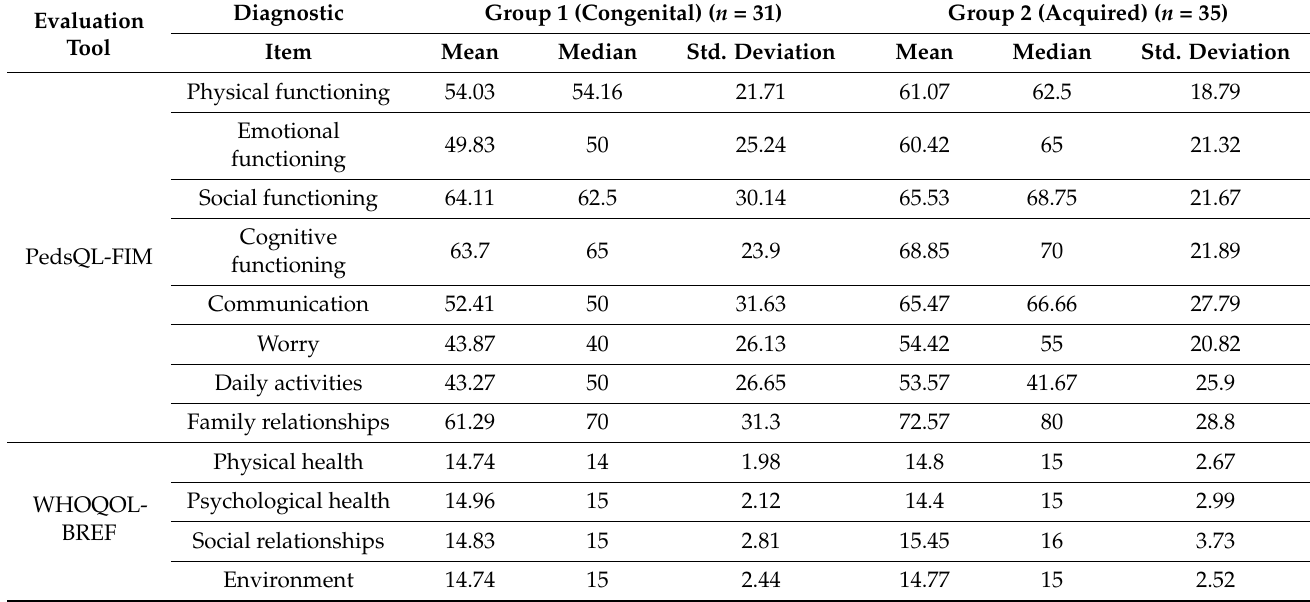
Table 2. Descriptive statistics for each tool for both